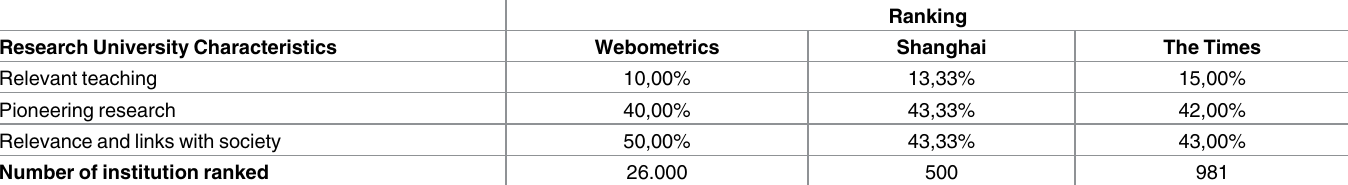
Table 1. Link between international rankings and research university characteristics. Created basedon [25]